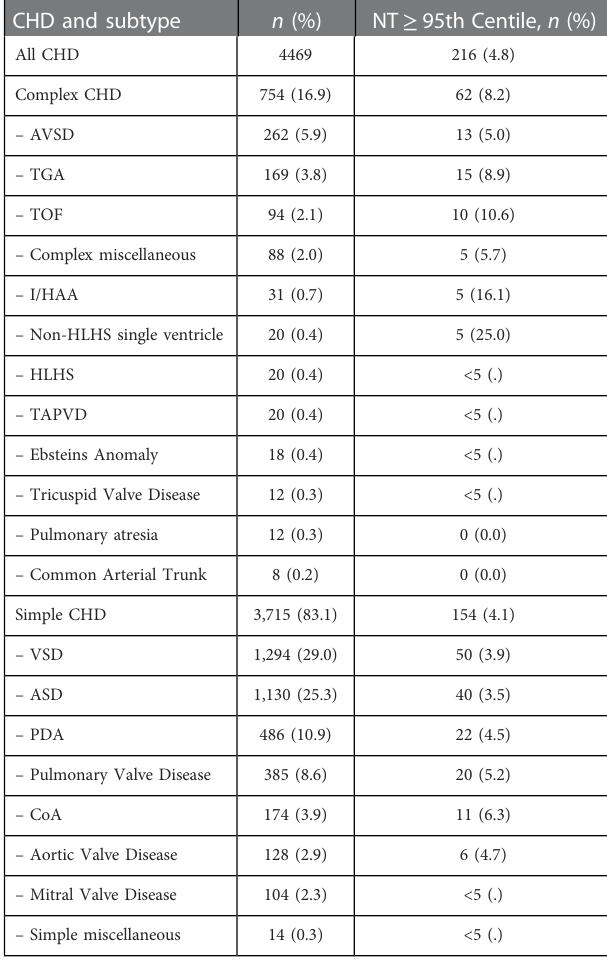
TABLE 2 Distribution of subtypes within simple and complex CHD and a NT ≥ 95th